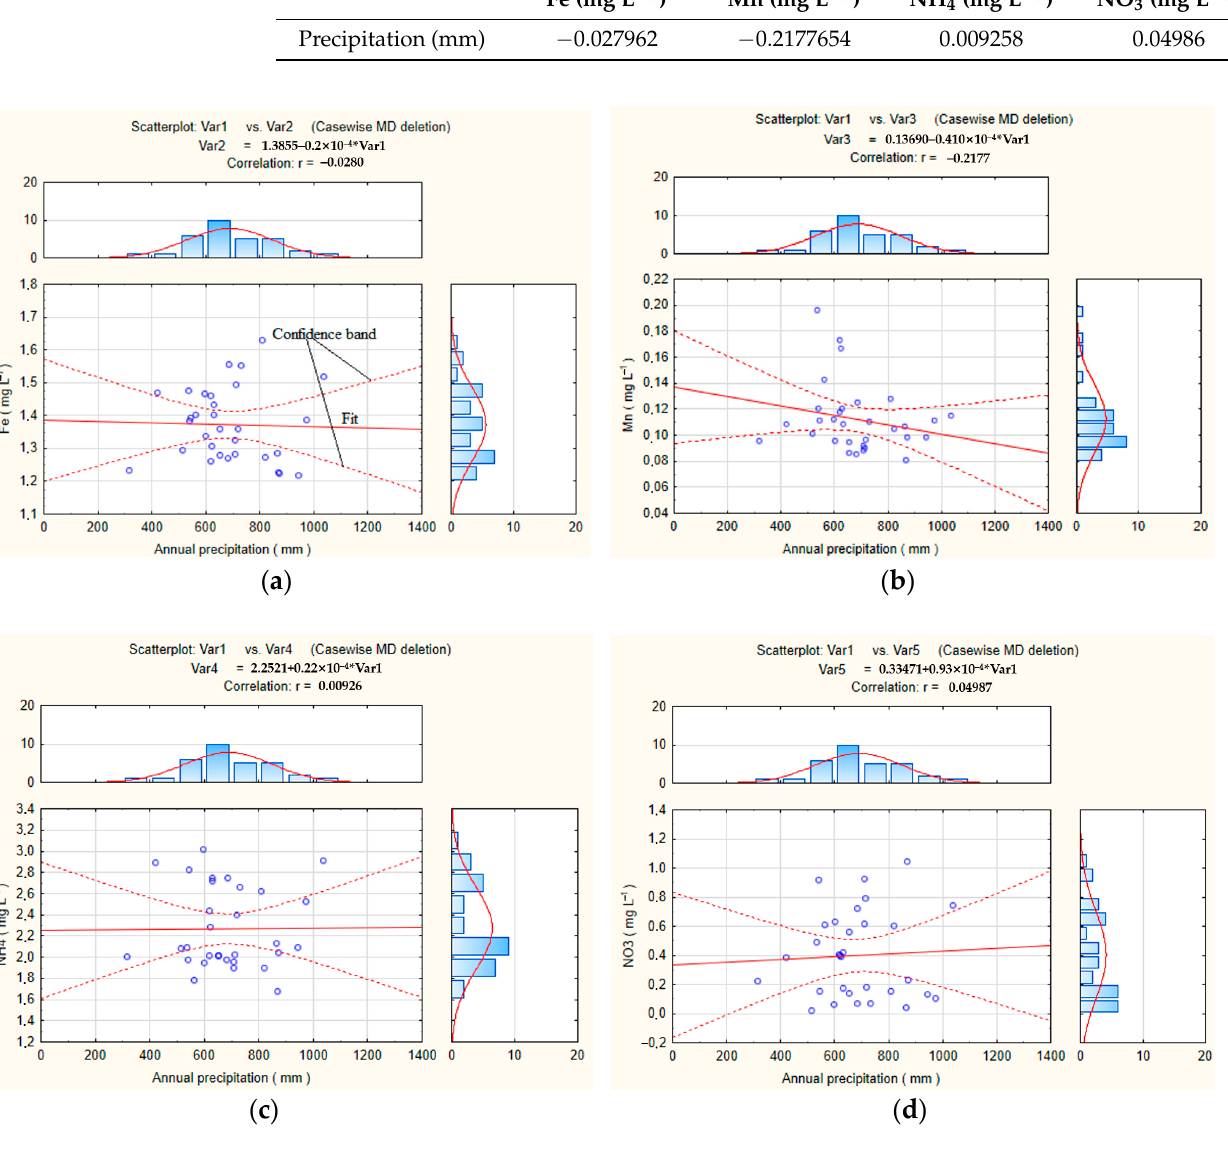
Figure 17. Correlation of annual precipitation and concentration of ( a ) iron; ( b ) manganese; ( c ) am- monia; and ( d ) nitrate in groundwater in the period 1984–2015.